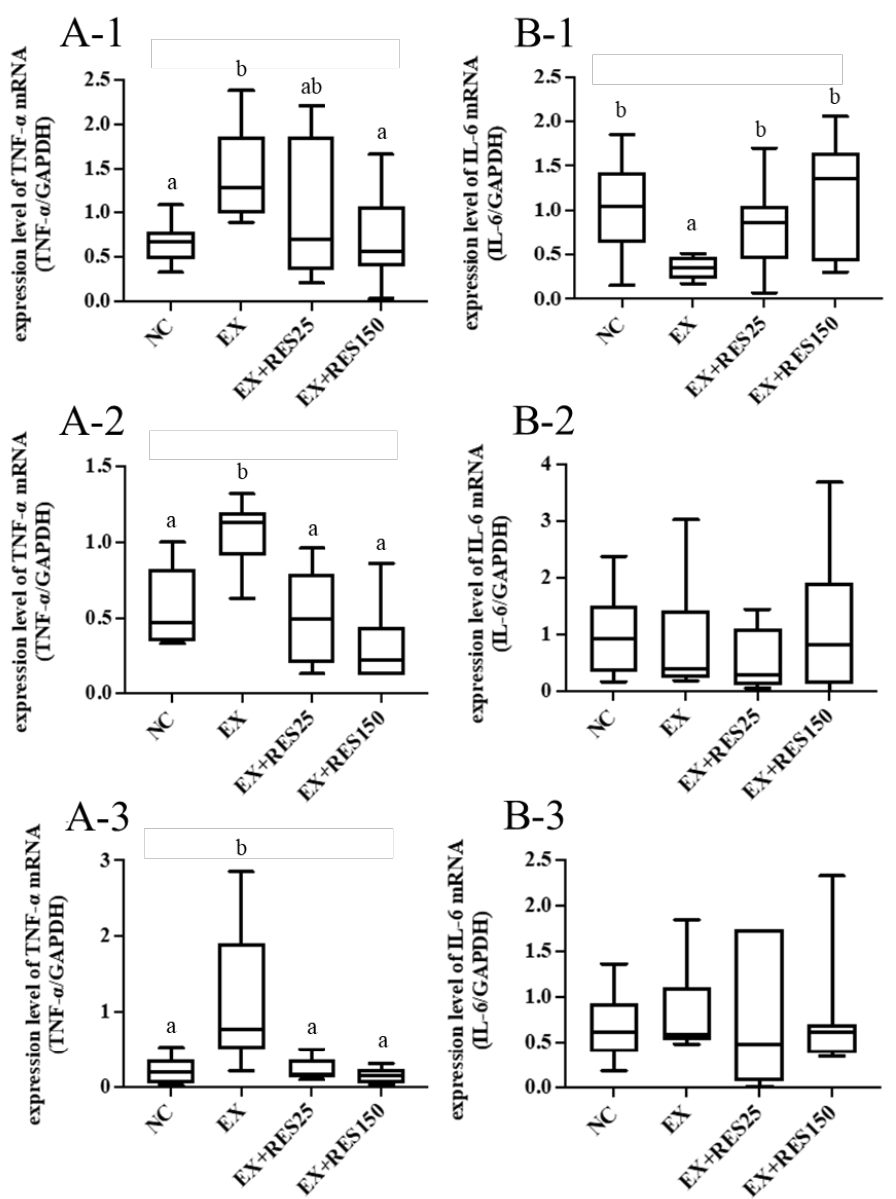
Figure 4. Effects of resveratrol on inflammatory cytokines ( A ) Tnf α and ( B ) IL-6 mRNA expression in (1) gastrocnemius muscle, (2) tibialis anterior muscle, and (3) soleus muscle during short-duration downhill running. mRNA expression was normalized to GAPDH and expressed as fold change relative to the control group. NC: control ( n = 6); EX: exercise ( n = 6); EX + RES25: exercise with resveratrol 25 mg/kg ( n = 6); EX + RES150: exercise with resveratrol 150 mg/kg ( n = 6). Data are presented as mean ± SEM. Data were analysed using one-way analysis of variance and a t-test followed by the Bonferroni multiple comparison test. Superscript letters (a and b) in columns denote a significant difference ( p < 0.05).